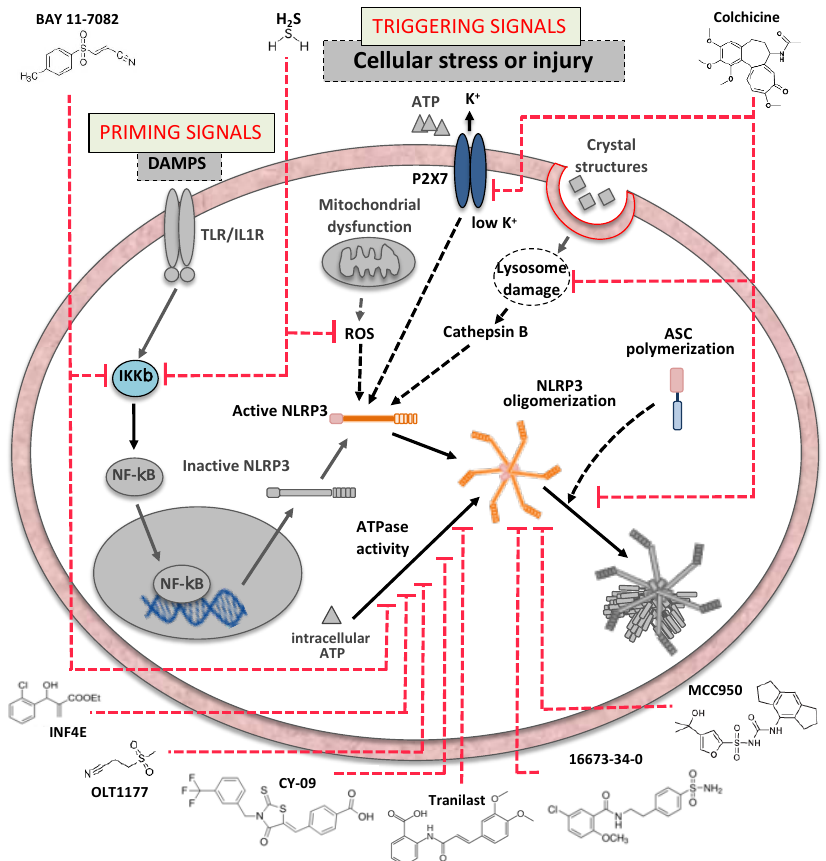
Figure 3. Inflammasome inhibitors tested in the cardiovascular system are reported together with the molecular target and mechanism of action. DAMPs, damage-associated molecular patterns; TLRs, Toll-like receptors; IL-1R, interleukin- 1 receptor; IKKβ , inhibitor of kappa B kinase β; NF - κ B, nuclear factor kappa B; P2X7, Purinergic receptor 2 X 7; ROS, reactive oxygen species; NLRP3, NACHT, leucine-rich repeat (LRR), and pyrin domain (PYD)-containing protein 3; ASC, apoptosis-associated speck-like protein containing a caspase recruitment domain.